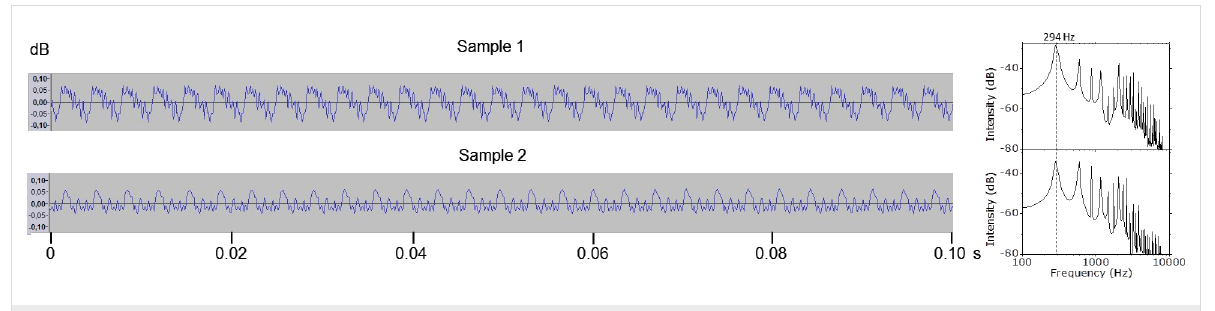
Figure 3: Sound waves and Fourier analyses of samples 1 and 2 after cleaning.